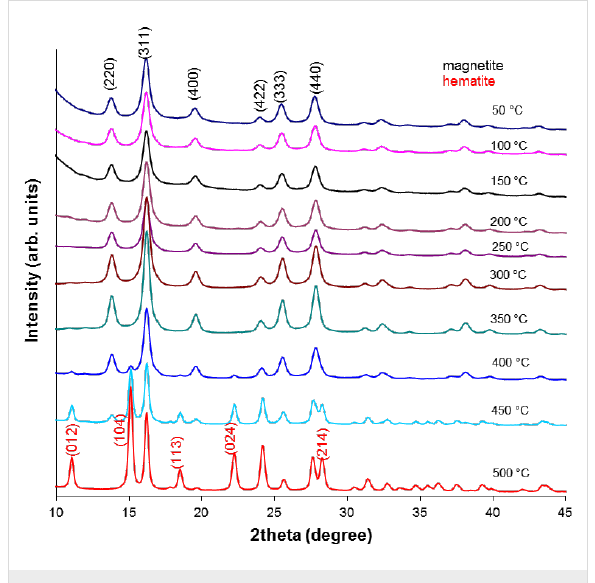
Figure 4: X-ray pattern of MNP-2 nanoparticles after the heating process.